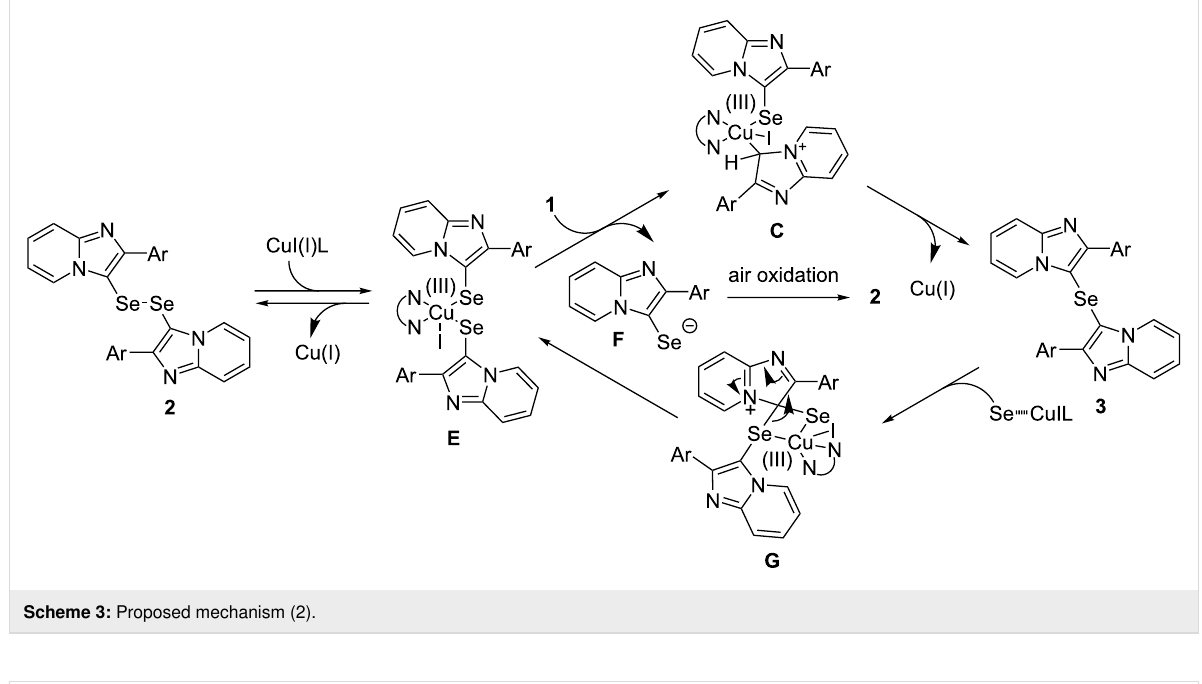
Scheme 3: Proposed mechanism (2).